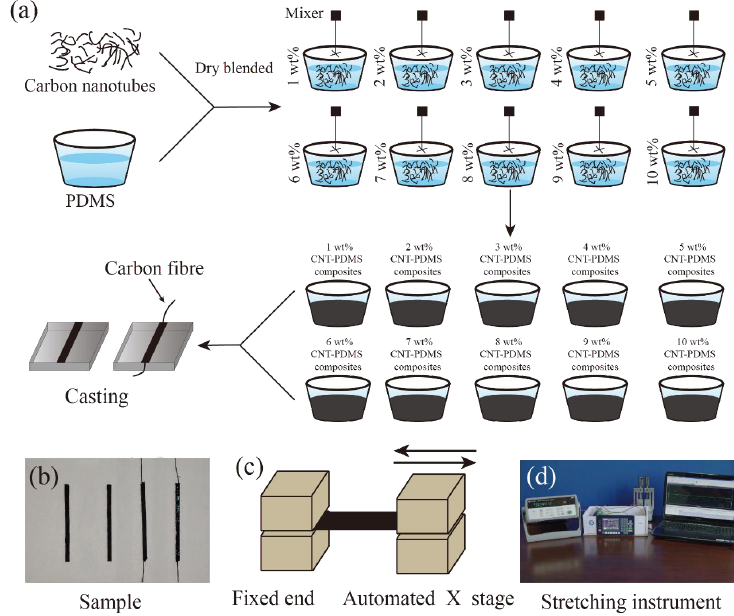
( b ) image of CNT-PDMS composites samples. The right side is the sample with carbon fiber embedded at both ends. The same process was used to prepare standard samples without embedding carbon fiber. ( c ) The schematic for the cyclic stretching test. ( d ) The custom-made platform for stretching samples of CNT-PDMS